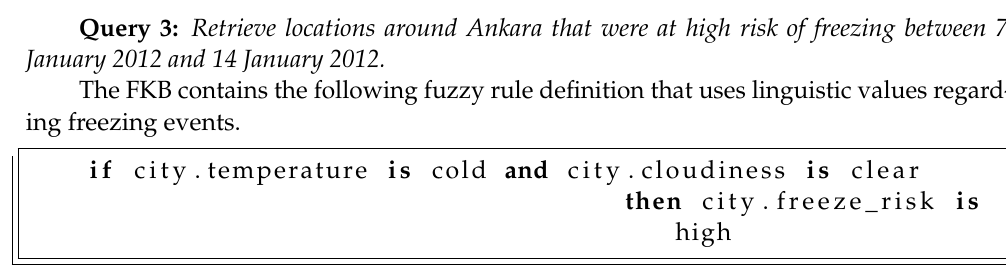
Figure 14. Fuzzy spatiotemporal query flow.